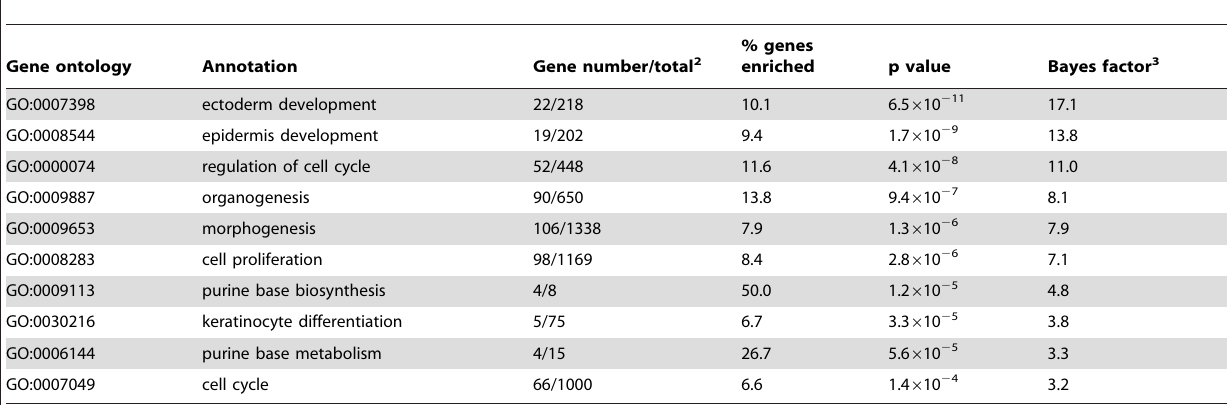
Table 3. GATHER GO Analysis of the Human Airway Basal Cell-enriched Transcriptome. 1